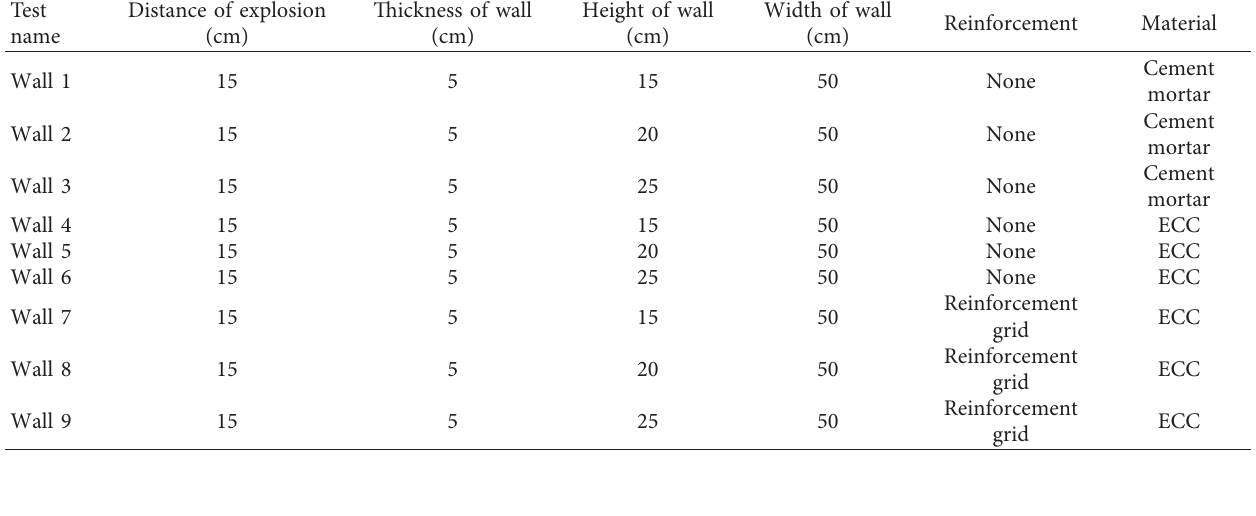
Table 1: Test conditions of explosion-proof wall models.